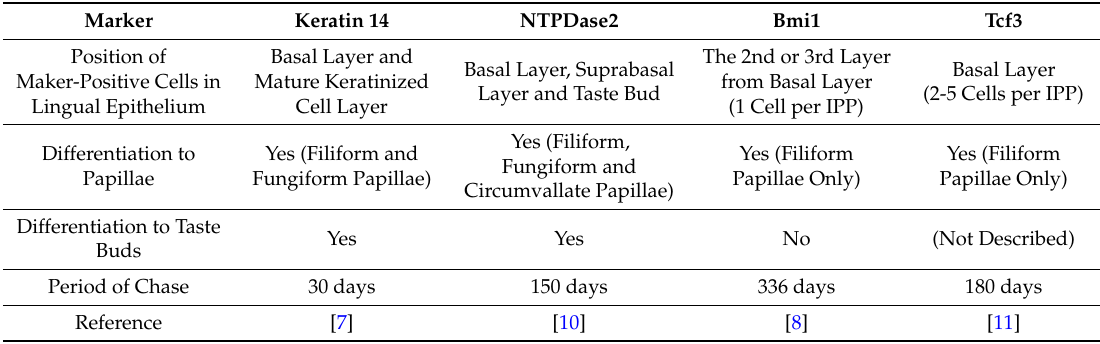
Table 1. Markers of lingual epithelial stem cells (LESCs) and the results of their lineage tracing